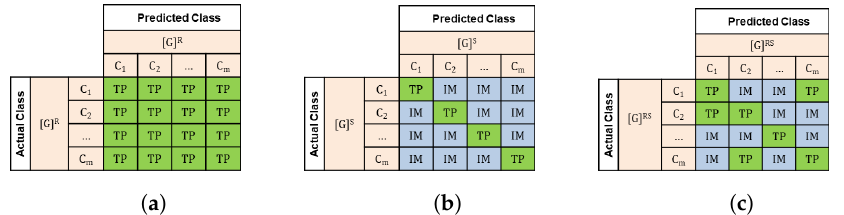
Figure 3. True positive instances definition examples. ( a ) TP for relaxed grouping. ( b ) TP for strict grouping. ( c ) Example TP for hybrid